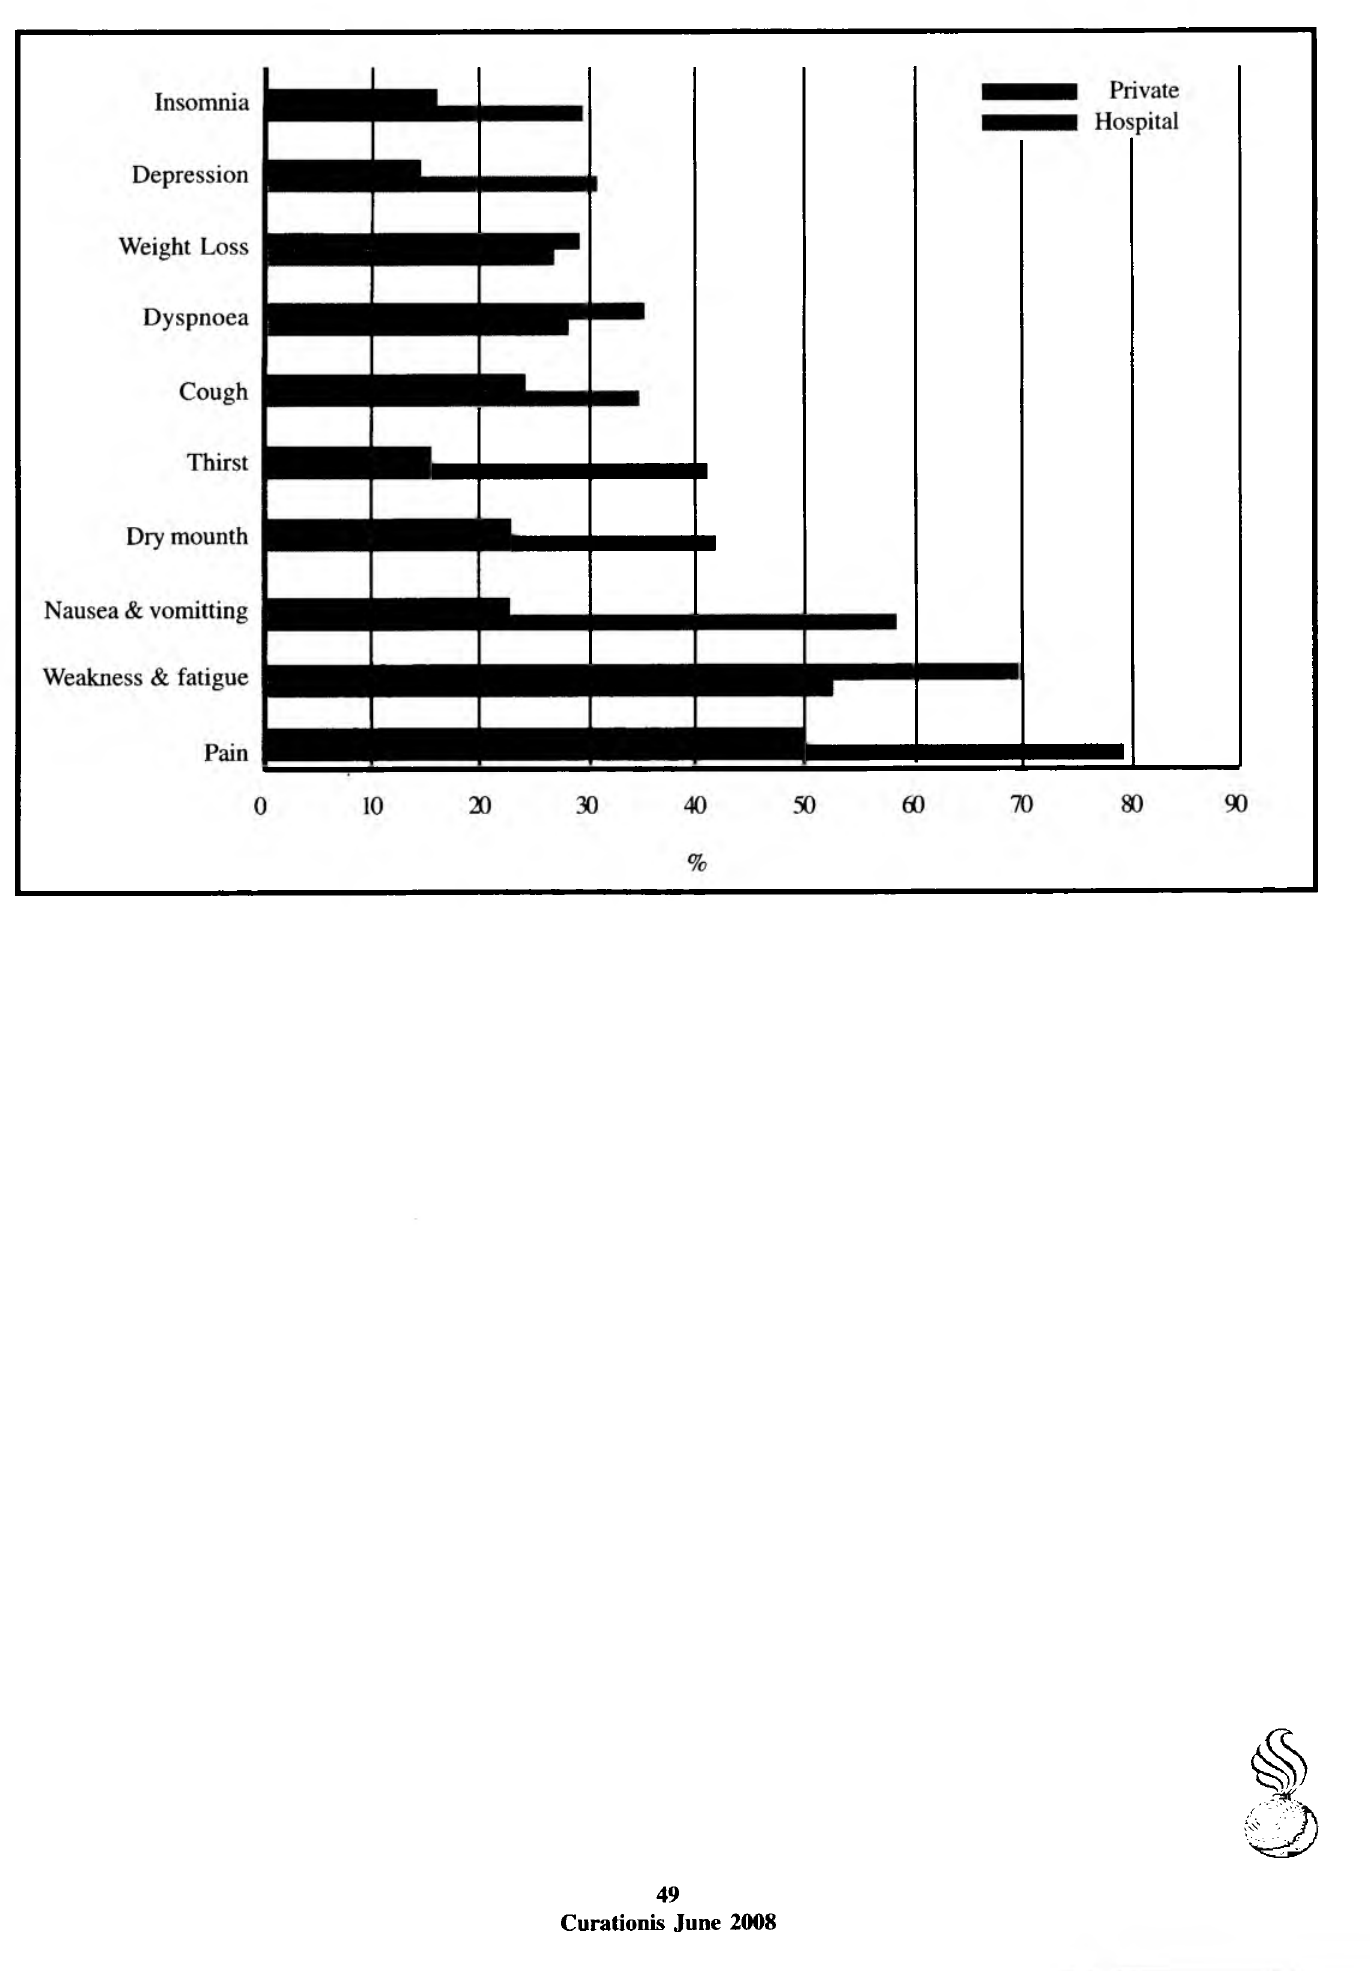
FIGURE 3: Comparison of symptoms of patients treated at a public hospital (n=62) versus patients treated at a private hospital (n=38) reflected as a percentage of the